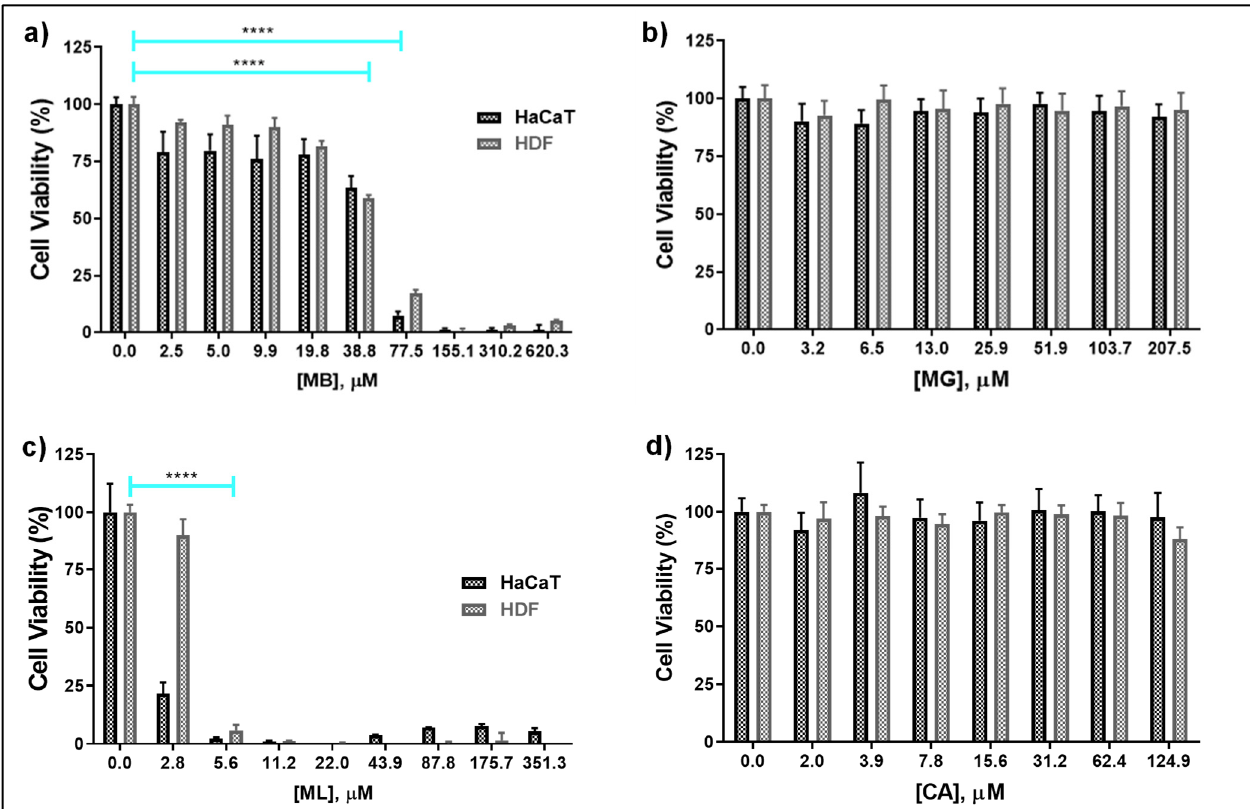
Figure 1. Cytotoxicity of pore-forming peptides for HaCaT and HDF cells, determined by MTS assay. ( a ) MB; ( b ) MG; ( c ) ML; ( d ) CA. Each bar represents mean ± s.d. from three independent triplicate experiments. Confluent cells were treated with increasing concentrations of indicated peptides. After 24 h, the metabolic activity of cells was quantified by MTS-based assay and the absorbance values, normalized in comparison to untreated control, were presented as cell viability (%). Note that MB decreased the metabolic activity of the cells at elevated concentrations (>38.8 μ M) whereas heightened cytotoxicity was observed for cell treated with low concentrations of ML. **** p < 0.0001 compared to corresponding untreated (0.0) controls as determined by Dunnett’s multiple comparison test.